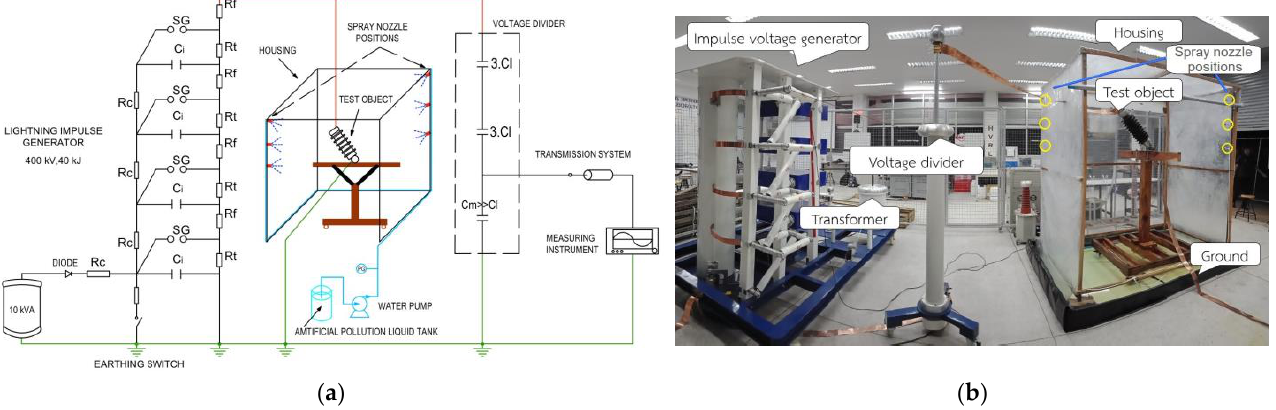
Figure 9. The experimental circuit of the lightning impulse critical-flashover voltage under contam- inated condition test. ( a ) The circuit diagram on the lightning impulse critical-flashover voltage test; ( b ) The test circuit set-up on the lightning impulse critical-flashover voltage test.